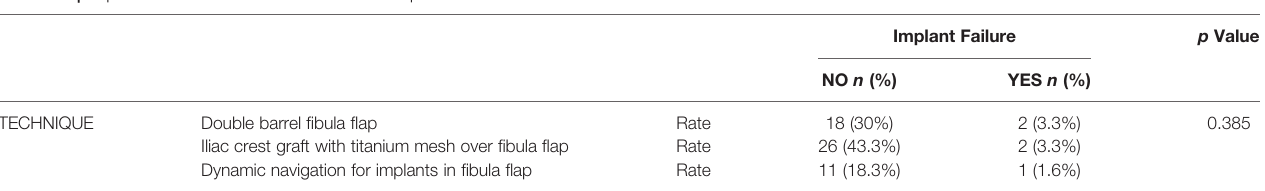
TABLE 2 | Implant failure between the different techniques.